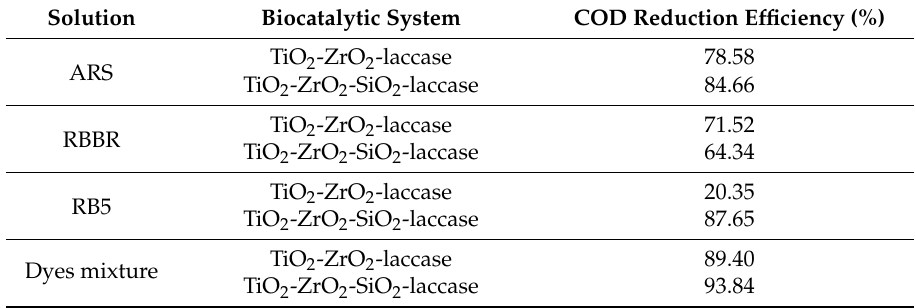
Table 5. Chemical oxygen demand (COD) determination of dyes after 24 h degradation in the presence of TiO 2 -ZrO 2 -laccase and TiO 2 -ZrO 2 -SiO 2 -laccase. Each of solution was at 5 mg/L concentration, pH 5 and temperature of 25 ◦ C. The errors of all measurements do not exceed